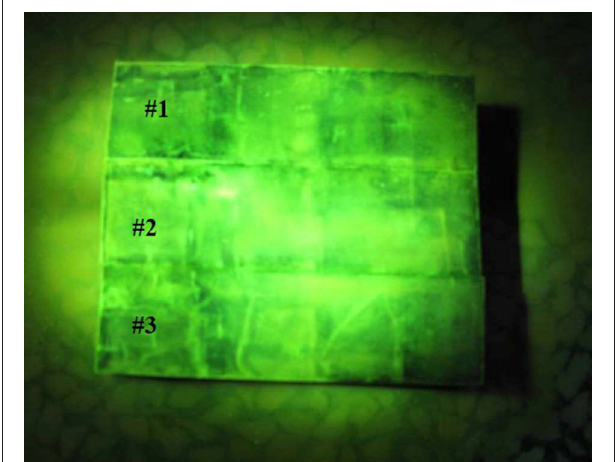
FIGURE 3 | Macrograph of surfaces of test samples after wet magnetic particle testing.